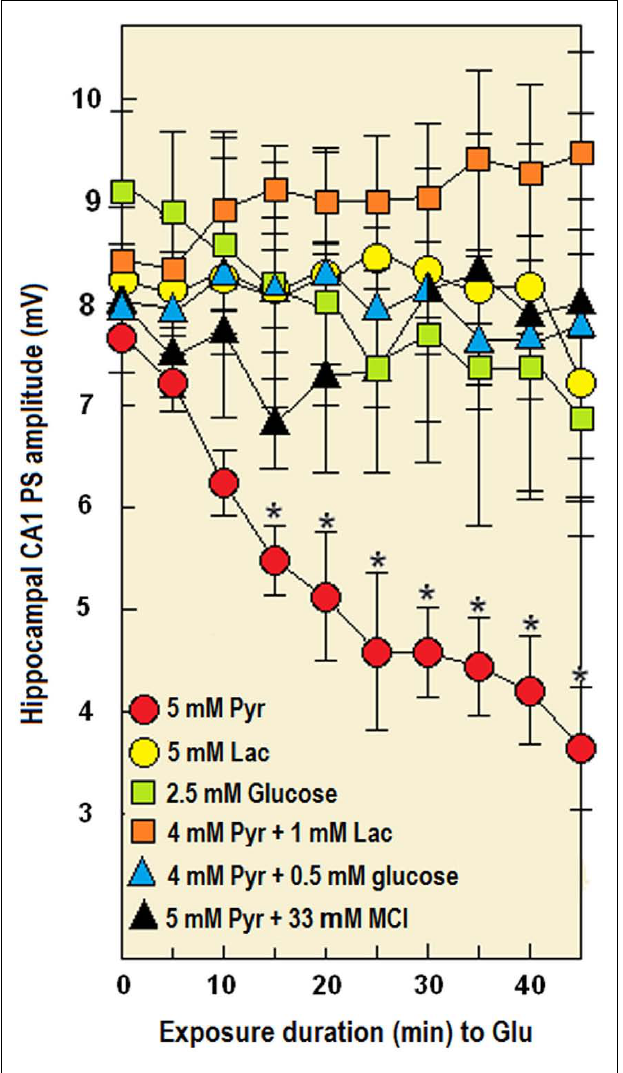
FIGURE 8 |The time-dependent effect of Glut (2.5mM) on the amplitude of electrically evoked CA1 population spike (PS, neuronal function) in rat hippocampal slices perfused with either 5mM pyruvate (Pyr), 5mM lactate (Lac), a mixture of pyruvate (4mM) with lactate (1mM), or MCI-186 (33 μ M, MCI). Pyruvate alone could not support neuronal function in the presence of glutamate, but mixing this monocarboxylate with a low concentration of either lactate, glucose, or MCI-186 overcame this inability. Each point is the mean amplitude value recorded from three separate hippocampal slices prepared from three different rat brains. Bars are SE of the mean. *Significantly different from the PS amplitude in slices perfused with pyruvate in the absence of glutamate ( p <